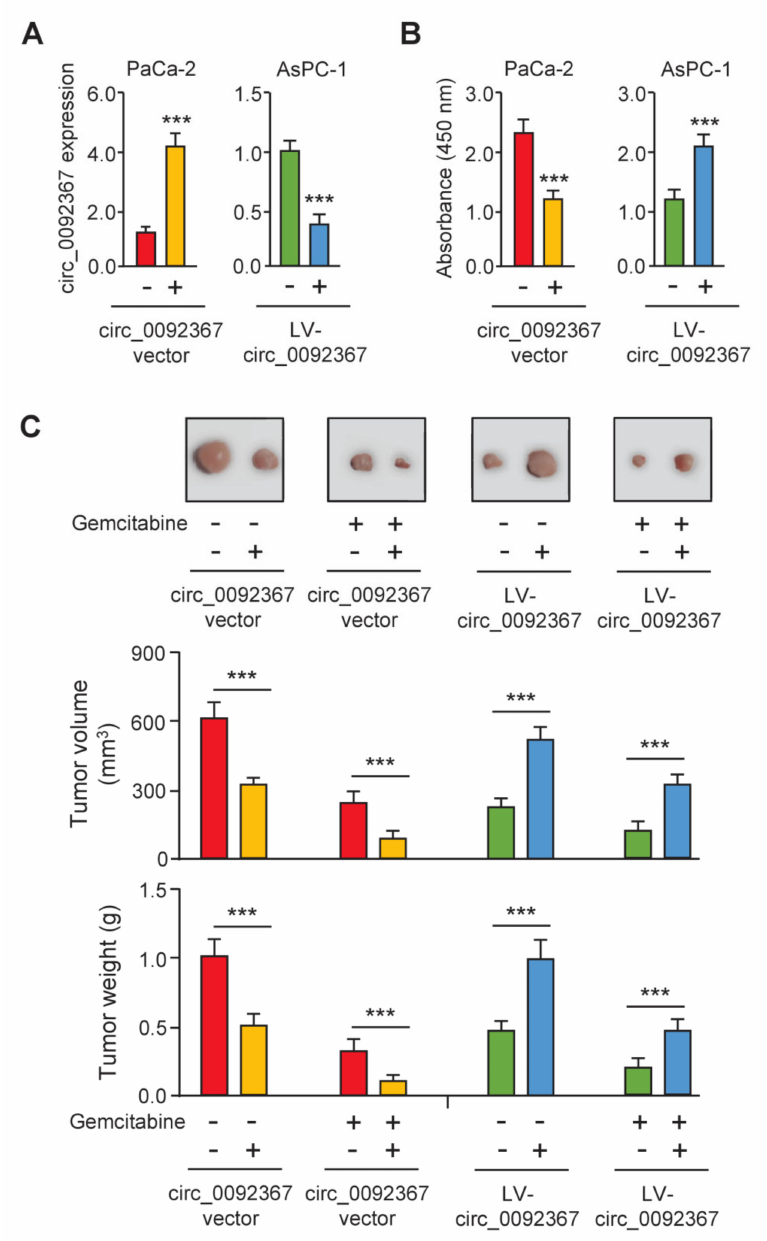
Figure 2. Overexpression of Circ_0092367 Inhibits PC Growth and Gemcitabine Resistance in Vivo. ( A ) Circ_0092367 expression in PaCa-2 cells transfected with circ_0092367-expressing vector or empty vector, or AsPC-1 cells after transfection of LV-circ_0092367 or LV-scramble, was assessed using qRT-PCR analysis. ( B ) CCK-8 assay in PC cells after overexpression or silencing of circ_0092367. ( C ) Xenograft tumor models were established using PaCa-2 cells transfected with circ_0092367- expressing or empty vector and AsPC-1 cells after transfection of LV-circ_0092367 or LV-scramble. Representative images of PaCa-2 or AsPC-1 tumors in nude mice treated with (or without) gemc- itabine (upper). Tumor volume and tumor weight (bottom) were assessed for each derived xenograft tumor. The experiments in ( A , B ) were repeated three times independently with similar results. *** p